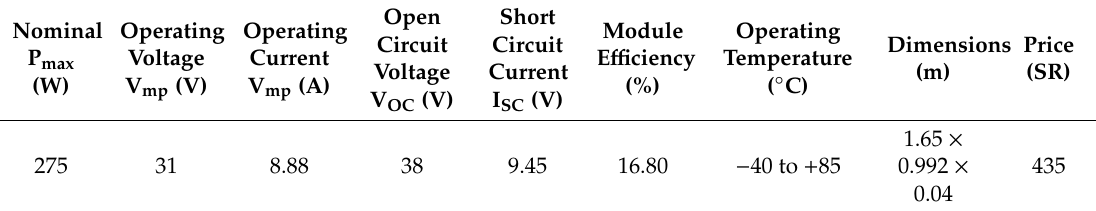
Table 5. Parameter of designed PV system (from GIS model).